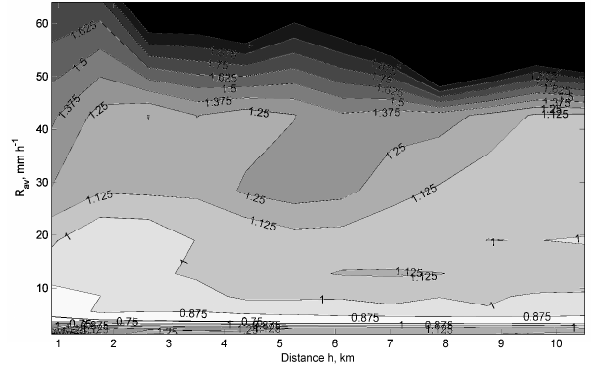
, (Eq. 48), as a function of gauge 3 sp